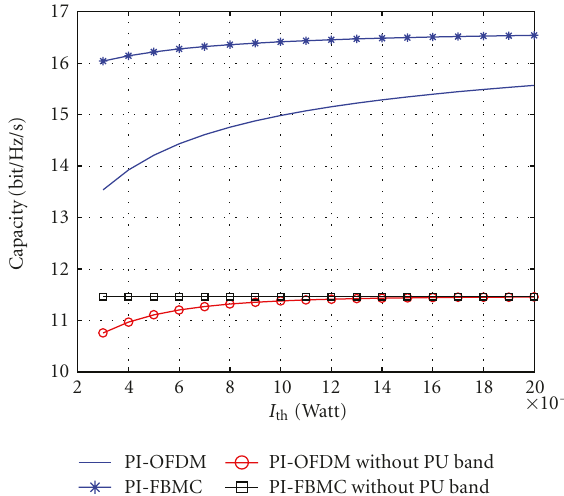
Figure 11: Achieved capacity versus allowed interference threshold with and without transmitting over active bands—two active PU bands.